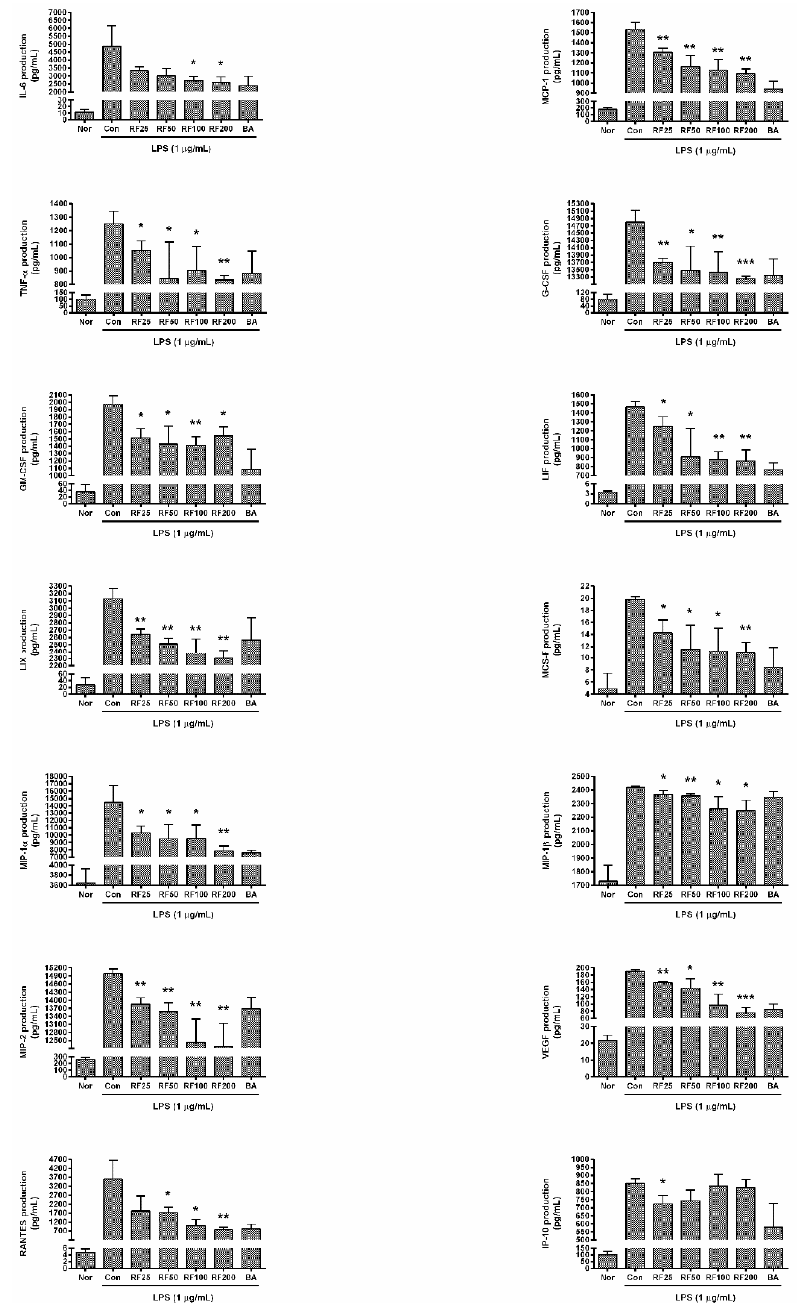
Figure 2. Effects of Rubi Fructus water extract (RF) on the production of interleukin (IL)-6, monocyte chemotactic activating factor (MCP)-1, tumor necrosis factor (TNF)- α , granulocyte-colony stimulating factor (G-CSF), granulocyte macrophage colony-stimulating factor (GM-CSF), leukemia inhibitory factor (LIF), lipopolysaccharide-induced CXC chemokine (LIX), macrophage colony-stimulating factor (M-CSF), macrophage inflammatory protein (MIP)-1 α , MIP-1 β , MIP-2, vascular endothelial growth factor (VEGF), and regulated on activation, normal T cell expressed and secreted (RANTES), and interferon gamma-induced protein (IP)-10. Cells were treated for 24 h with LPS and RF. “Nor” indicates the group treated with media only. “Con” indicates the group treated with 1 µ g / mL of LPS alone. RF25, RF50, RF100, and RF200 indicate 25, 50, 100, and 200 µ g / mL of RF, respectively. “BA” indicates treatment with baicalein (25 µ M). Values represent means ± SD of three independent experiments ( n = 3). Statistical significance was calculated by one-way ANOVA and a Tukey multiple comparison test. * p < 0.05 vs. Con; ** p < 0.01 vs. Con; *** p < 0.001 vs.